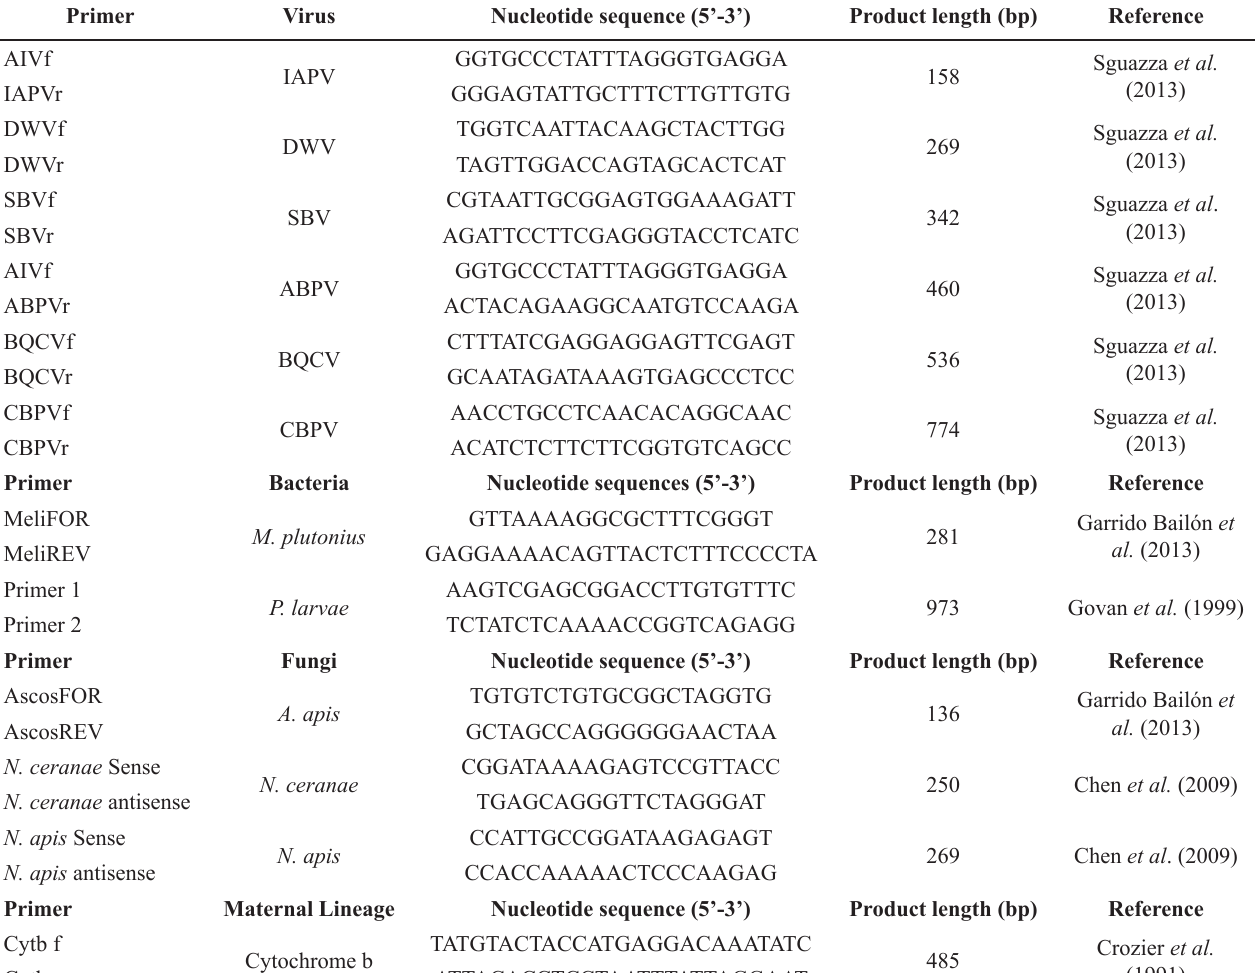
Table 1 . Analyses of A. mellifera from General Alvear, Buenos Aires, Argentina: Primers used for pathogens and maternal lineages detection. [ABPV = Acute Bee Paralysis Virus ; BQCV = Black Queen Cell Virus ; CBPV = Chronic Bee Paralysis Virus ; DWV = Deformed Wing Virus ; IAPV = Israeli Acute Paralysis Virus ; KBV = Kashmir Bee Virus ; M. plutonius = Melissococcus plutonius ; N. apis = Nosema apis ; N. ceranae = Nosema ceranae ; P. larvae = Paenibacillus larvae ; SBV = Sacbrood Virus